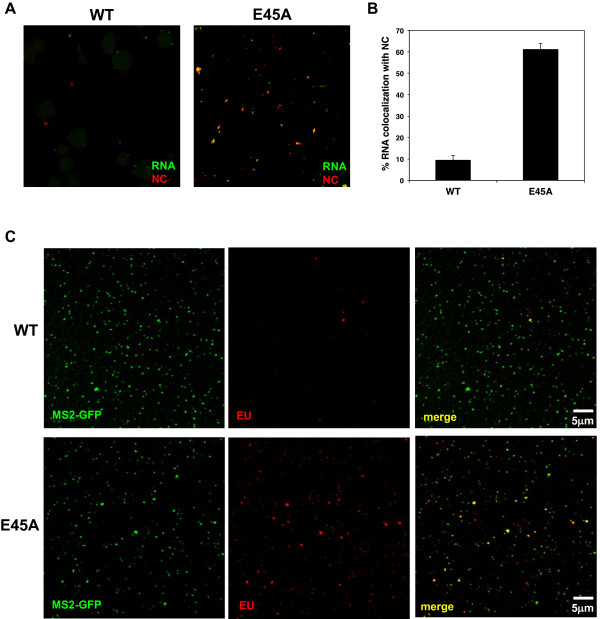
E45A HIV-1 cores allow vRNA and NC staining more readily than WT HIV-1 cores. (A) Equal amounts of p24 of EU-labeled WT HIV-1 and E45A HIV-1 were treated with cell extraction buffer for 15 minutes, fixed onto slides, and then stained for EU (green) and NC (red). Particles were visualized by fluorescent confocal microscopy. (B) RNA staining of WT HIV-1 and E45A HIV-1 was counted alone and when co-localized with NC. The percentage of co-localized events for at least four fields was calculated. Data represent the mean ± SEM of at least 4 fields. (C) Equal amounts of p24 of EU-labeled WT HIV-1 and E45A HIV-1 also containing MS2-GFP (green) were treated with cell extraction buffer for 15 minutes, fixed, and stained for EU (red). Particles were visualized by fluorescent confocal microscopy and shown for each individual color and with both colors (merge).